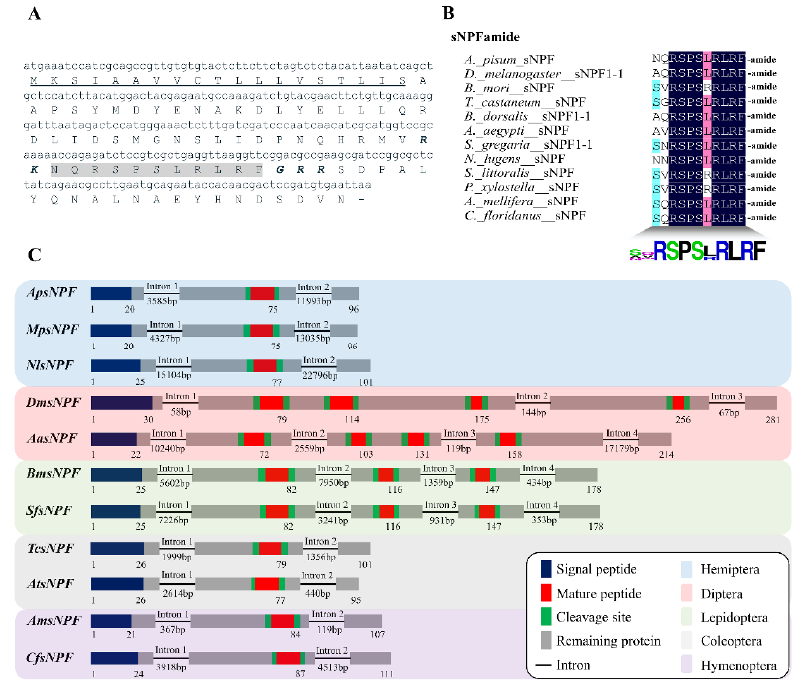
Figure 1. Bioinformatics analysis of short neuropeptide F (sNPF) from A. pisum . ( A ) Nucleotide and amino acid sequences of sNPF cDNA. The underlined letters are predicted signal peptides, grey background amino acids represent mature peptides, and italic and bold letters are the dibasic cleavage sites. ( B ) Amino acid sequence alignment of sNPFs with other insect species; at the bottom, there is a consensus logo. ( C ) Comparative analysis of exon/intron structure of the gene encodes ApsNPF with sNPF precursors of other insects. The diagram illustrates the gene structure, the rectangles are protein ‐ coding exons, and lines (with the length underneath) are the introns. Species abbreviation: Ap ( Acyrthosiphon pisum ), Mp ( Myzus persicae ), Nl ( Nilaparvata lugens ), Dm ( Drosophila melanogaster ), Aa ( Aedes albopictus ), Bm ( Bombyx mori ), Sf ( Spodoptera frugiperda ), Tc ( Tribolium castaneum ), At ( Aethina tumida ), Am ( Apis mellifera ), and Cf ( Camponotus floridanus ). Table S2 contains the accession numbers of precursors presented in this figure.